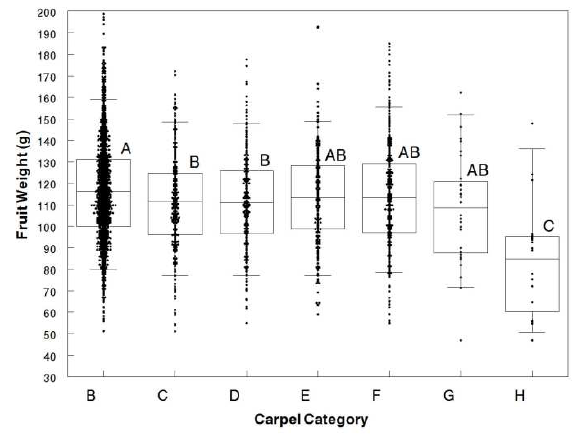
F IGURE 9. Apple fruit weight (box and whisker plot, central horizontal line showing mean, box = 25 th and 75 percentiles, whiskers = 5 th and 95 th percentiles) versus carpel category. Boxes sharing letters are not significantly different (Tukey’s HSD test, P = 0.05). Dots added to show number of fruit per carpel